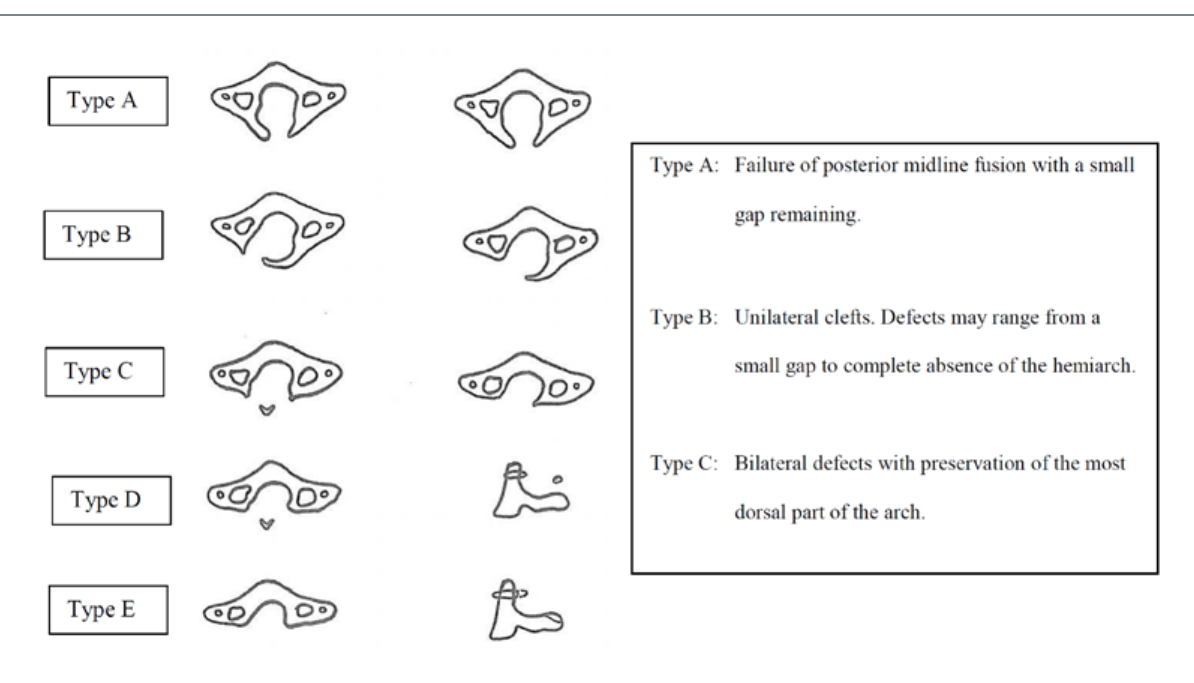
Figure 1. Classification of posterior arch defects of the atlas based on Currarino